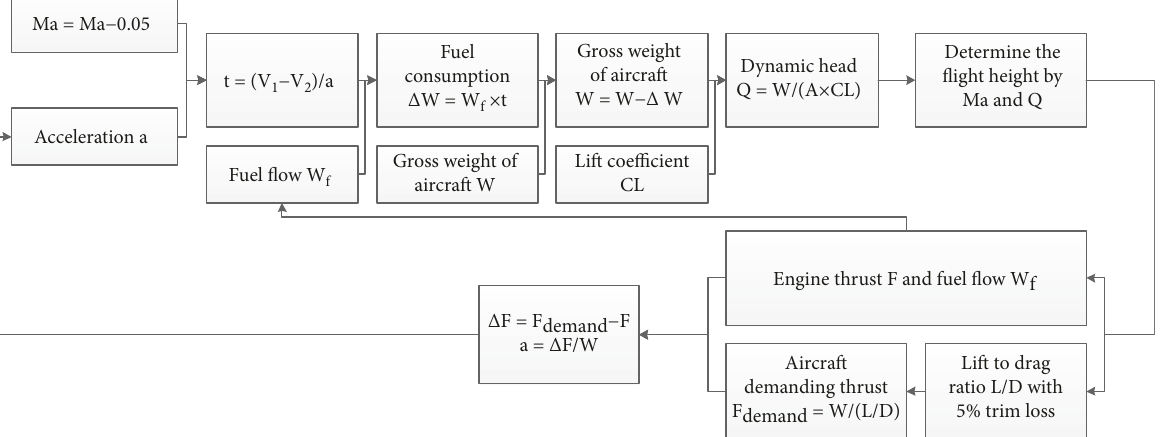
Figure 10: Single engine inoperative analysis fl ow chart.